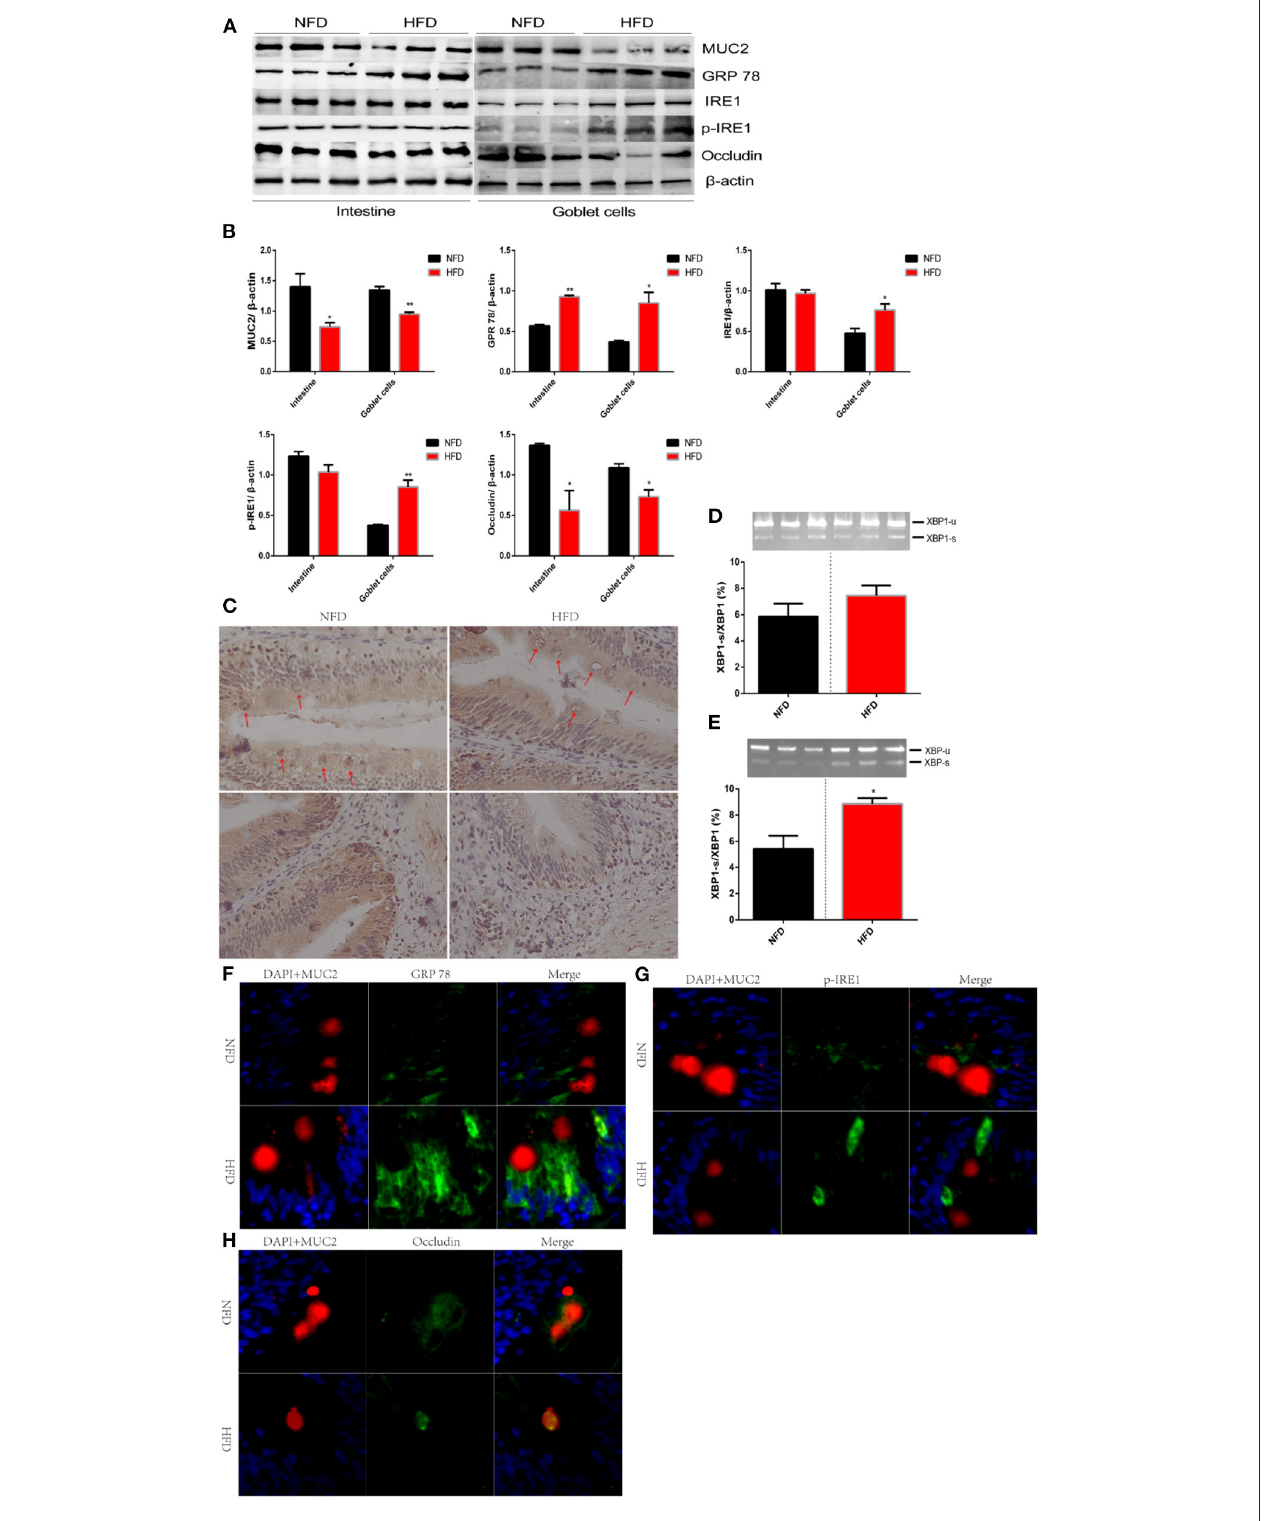
FIGURE 4 | High-fat diets increase intestinal permeability via disturbing the secretion of MUC2 in goblet cell. Fish were fed a normal-fat diet (5% fat, NFD) or high-fat diet (10% fat, HFD) for 12 weeks. (A) polyacrylamide gel electrophoresis (SDS-PAGE) of MUC2, GPR 78, IRE1, p-IRE1 and occludin in intestinal tissue or